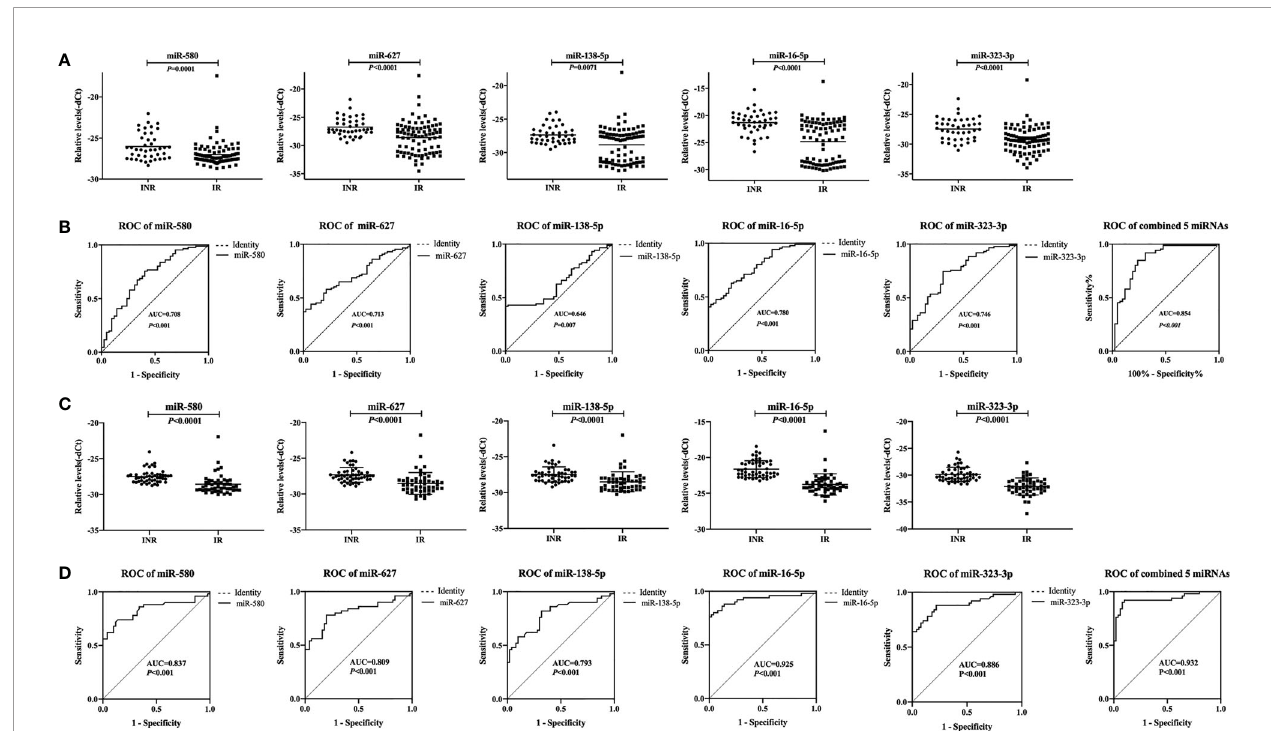
FIGURE 2 | Relative expression levels of fi ve plasma microRNAs (miRNAs) and analyses of receiver operating characteristic (ROC) curves in the validation phase. (A) Relative expression of fi ve miRNAs in immune non-responders (INRs, n = 42) and immune responders (IRs, n = 86) in the validation set. (B) Analyses of ROC curves of fi ve miRNAs and our combined fi ve-miRNA panel performed in the validation set. (C) Relative expression levels of fi ve miRNAs in INRs (n=50) and IRs (n=50) in the mixed test set. (D) Analyses of ROC curves of fi ve miRNAs and our combined fi ve-miRNA panel as performed in the mixed test set. The area under the ROC curve (AUC) value represents the diagnostic